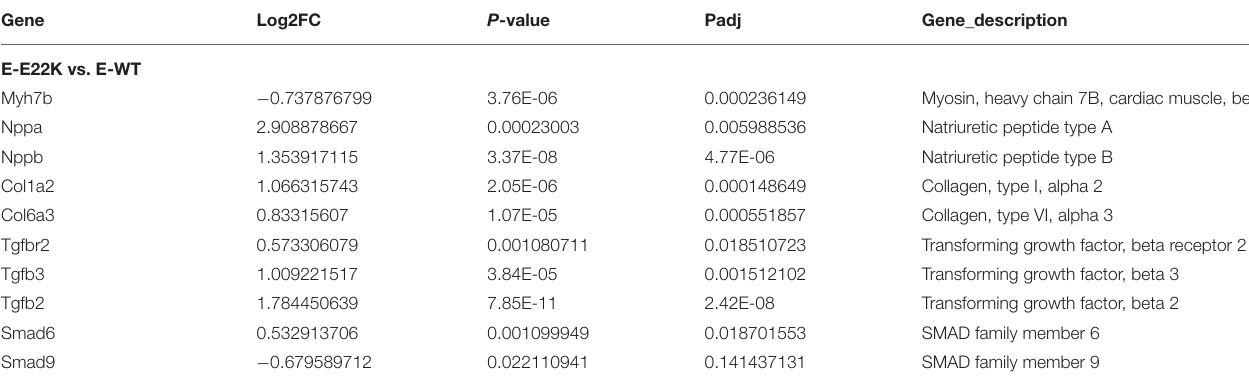
TABLE 4 | A list of significant DEGs between E22K and WT mice after exercise. Gene Log2FC P -value